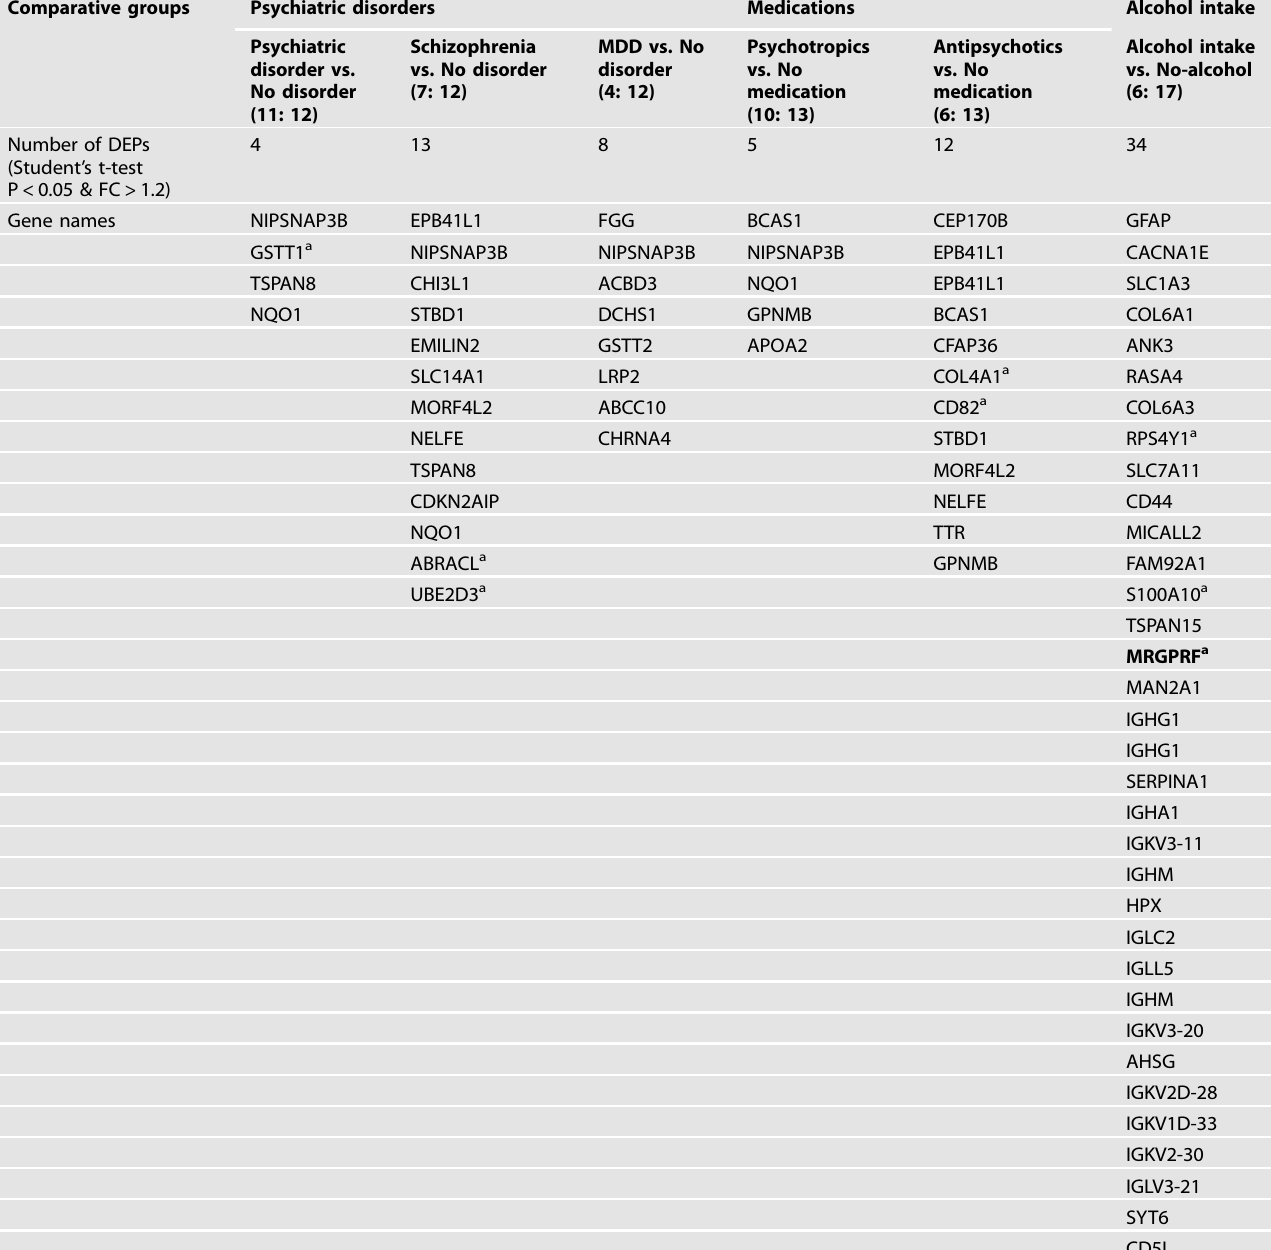
Table 2. Proteins related to clinical characteristics among suicide